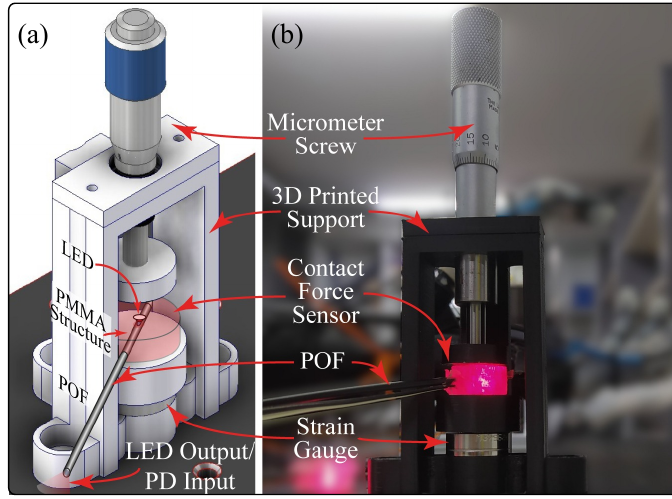
Figure 7. Test bench for the contact force sensor. ( a ) CAD. ( b ) Real